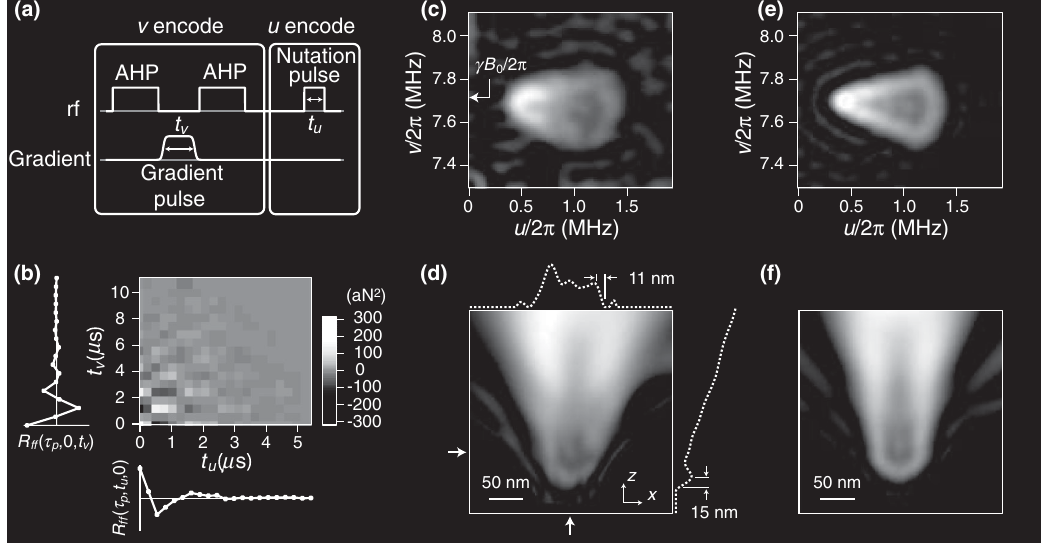
FIG. 4. Two-dimensional MRI of the polystyrene sample. (a) Image encoding sequence. In the v -encoding step, the spins precess in the presence of a gradient for a time t v . In the u -encoding step, the spins precess about the effective field in the rotating frame for a time t u . (b)Rawdata.Crosssectionscorrespondingto R ff ð (cid:5) p ; 0 ; t v Þ and R ff ð (cid:5) p ; t u ; 0 Þ areshown.(c)Signaldensityinthe ð u; v Þ coordinatesystem obtained by cosine transforming the raw data. The arrow indicates the position of (cid:4)B 0 = 2 (cid:2) . (d) Real-space reconstruction of the projected spin density. The nanowire and gold catalyst are clearly visible through the polystyrene in the image as a reduction in the spin density. The cross sections above and to the right of the image are taken along the lines indicated by the arrows. (e) Simulated signal density in ð u; v Þ space calculated for the sample and nanowire geometry shown in Fig. 1(b). (f) Real-space reconstruction of the simulation in